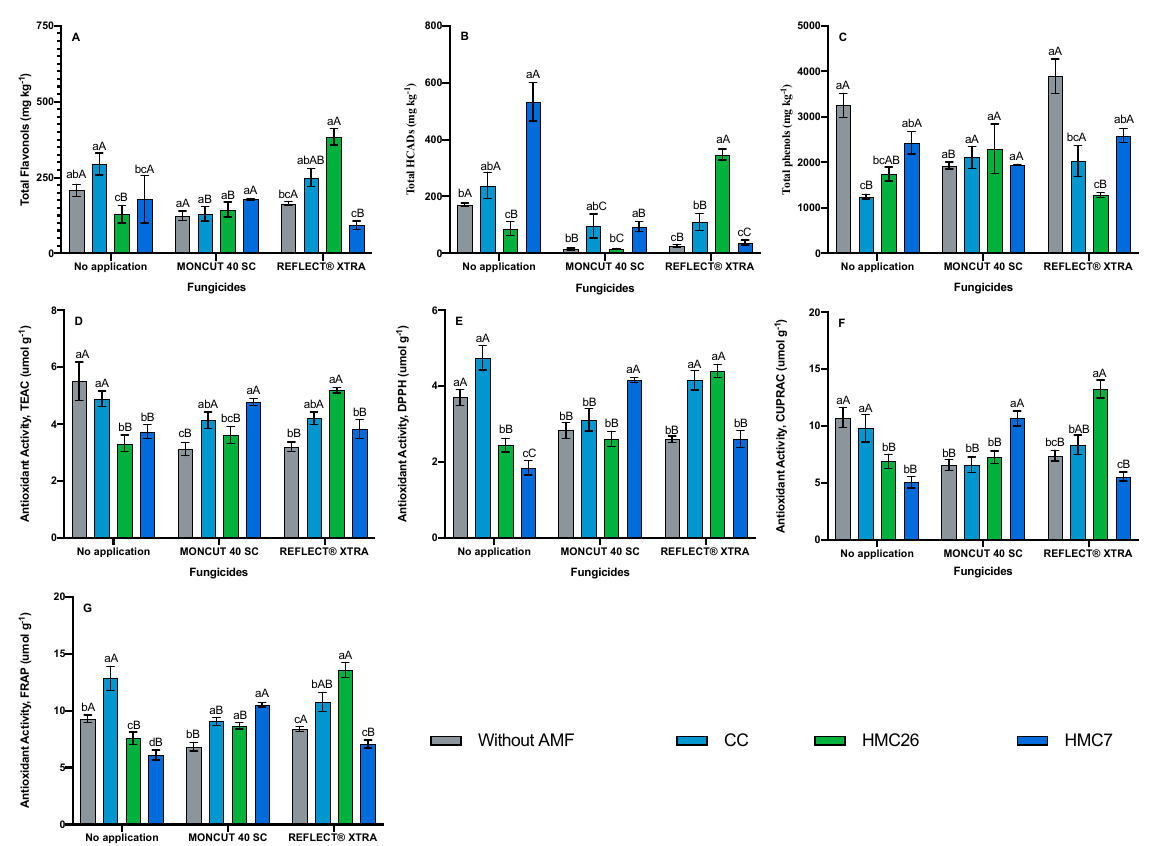
Figure 4. Phenolic compounds and antioxidant activity of Solanum tuberosum leaves, VR808 genotype under inoculation of arbuscular mycorrhizal fungi and fungicide treatments. ( A ) Total flavonols by HPLC-DAD, ( B ) Total hydroxycinnamic acids by HPLC-DAD, ( C ) Total phenols determined by the Folin-Ciocalteu method, ( D ) AA determined by the TEAC (Trolox equivalent antioxidant capacity) method, ( E ) AA determined by the DPPH (2,2-diphenyl-1-picrylhydrazyl) method, ( F ) AA determined by the CUPRAC (copper reducing antioxidant capacity) method and ( G ) AA determined by the FRAP (ferric reducing antioxidant power) assay. Means followed by the same lowercase letter compare inoculation for the same fungicide and uppercase letters compare fungicides within the same inoculation condition (Tukey 5%). Where: without AMF, CC: Claroideoglomus claroideum ; HMC26: Claroideoglomus lamellosum and HMC7: Funneliformis mosseae